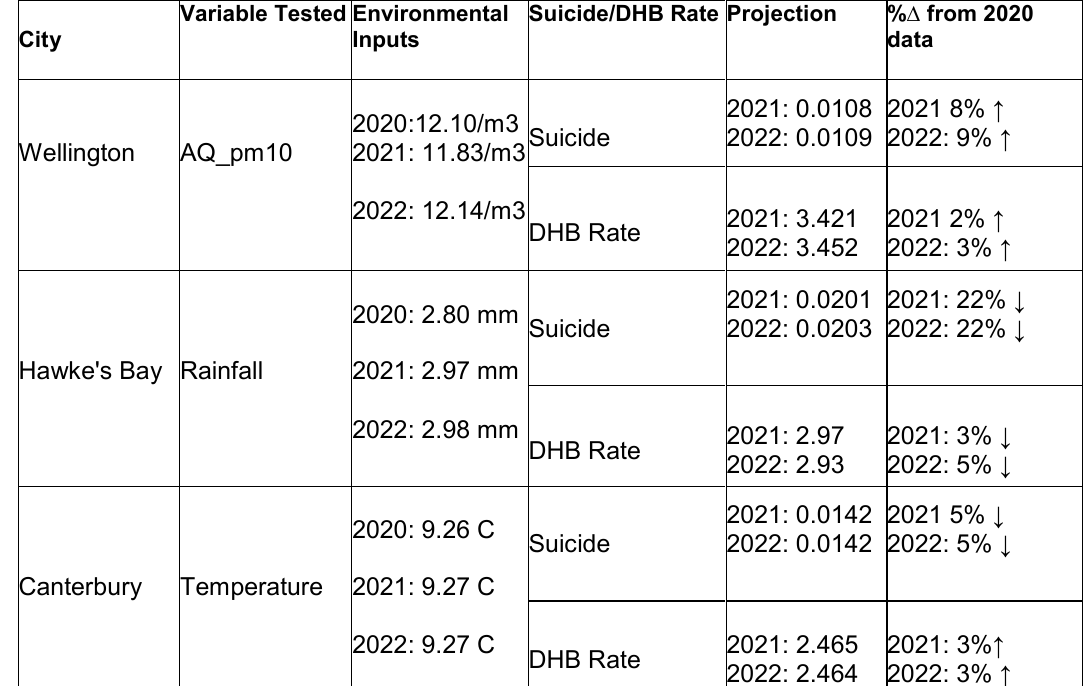
Table 1. Predicted Mental Health Data based on environmental predictions